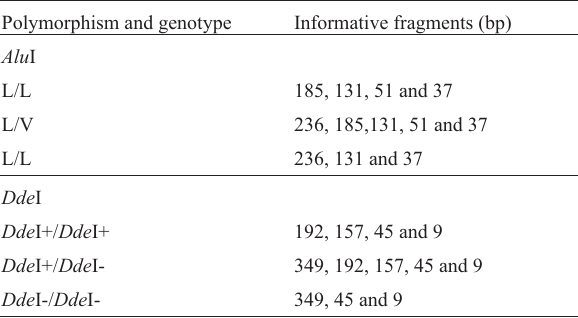
hormone 1 gene ( GH1 ) polymorphisms of Canchim